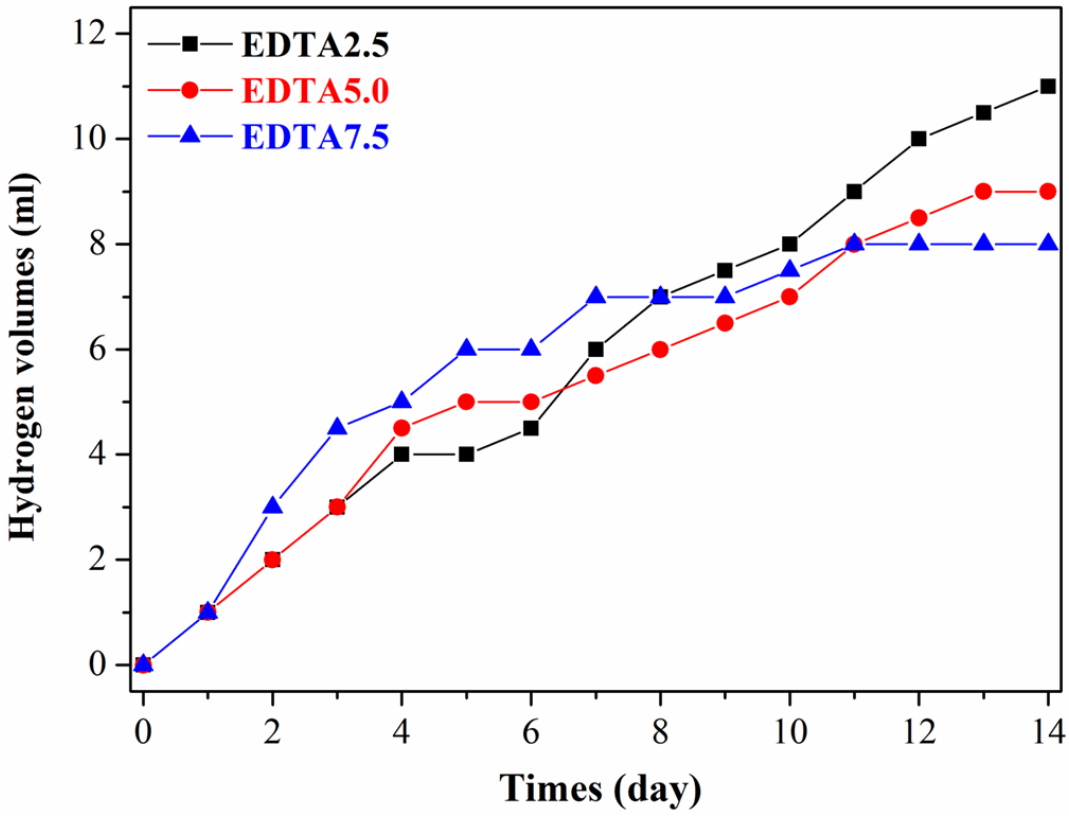
Figure 7. Records of the cyclic hydrogen evolution in SBF solution for the AZ31 sample treated in the various EDTA bath. Table 3. Hydrogen evolution, surface roughness, and porosity of the AZ31 sample treated in the various EDTA